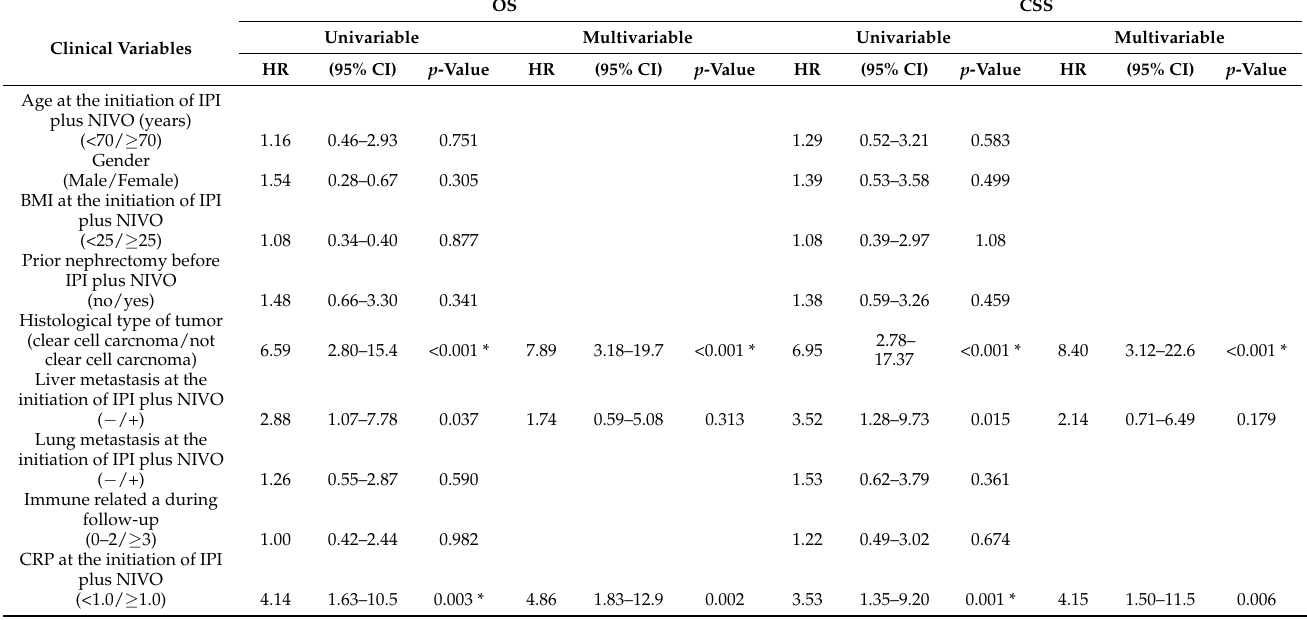
Table 4. Univariate and Multivariate analyses for predicting OS and CSS in mRCC treated by IPI plus